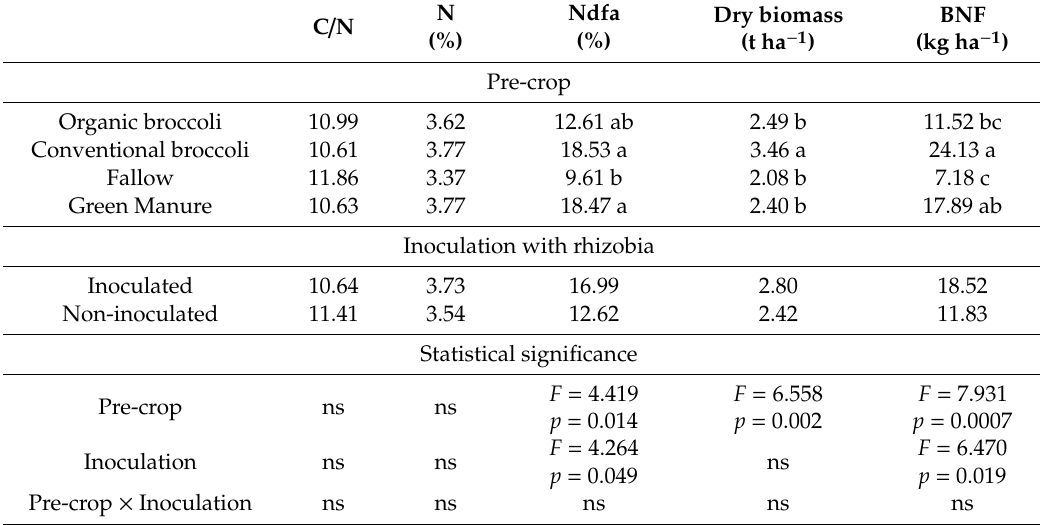
Table 6. Impact of the di ff erent pre-crop treatment and inoculation of common bean with Rhizobium tropici CIAT 899 on C / N ratio, N content (%), %Ndfa, dry biomass (t ha − 1 ), and amount of biological fixed N (BNF, kg ha − 1 ) of common bean cultivated during spring-summer 2018.